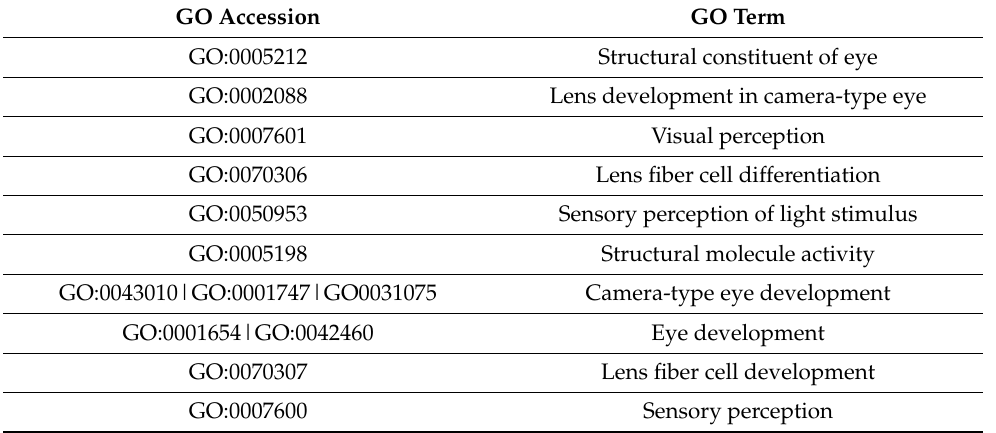
Table 4. Gene Ontology (GO)